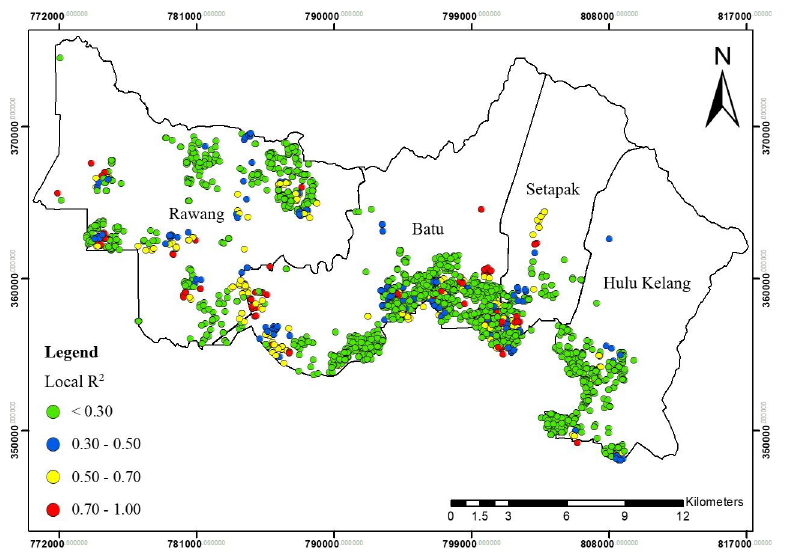
Fig 9. Spatial distribution of local R 2 for GWR1 in Gombak, 2013 to 2017.